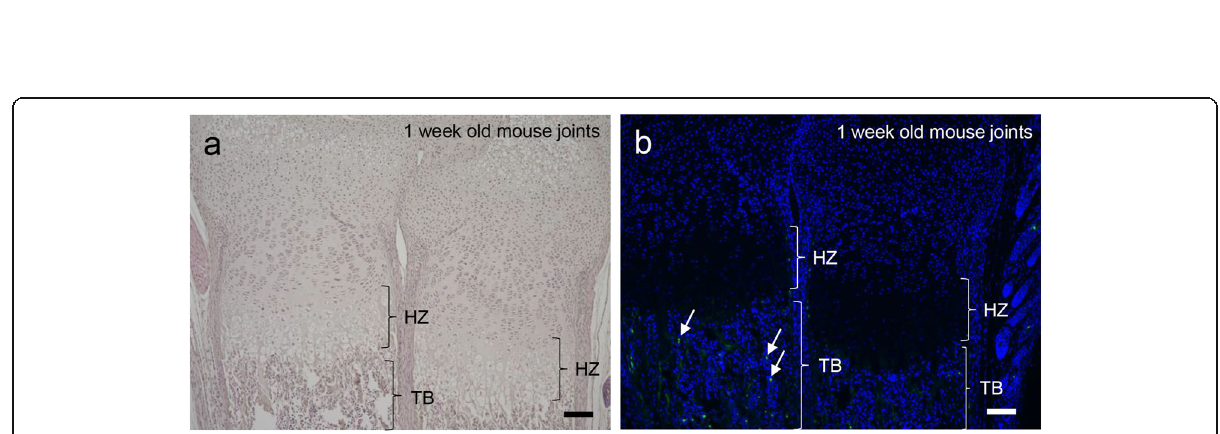
Fig. 4 Minor population of apoptotic cells in hypertrophic chondrocytes near the growth plate in the joint. a H&E staining of 1-week-old mouse joints. b TUNEL assay in 1-week-old mouse joints. Apoptotic cells are indicated by arrows in trabecular bone (TB). There are no apoptotic cells in the hypertrophic zone (HZ). Scale bar = 100 μ